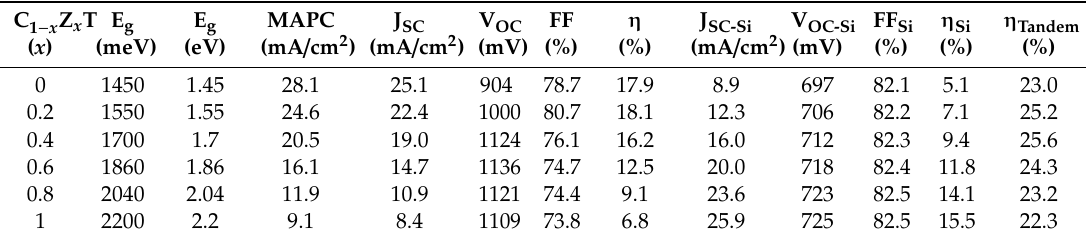
Table 4. Electrical and optical device simulation data for a normal top cell structure with 50